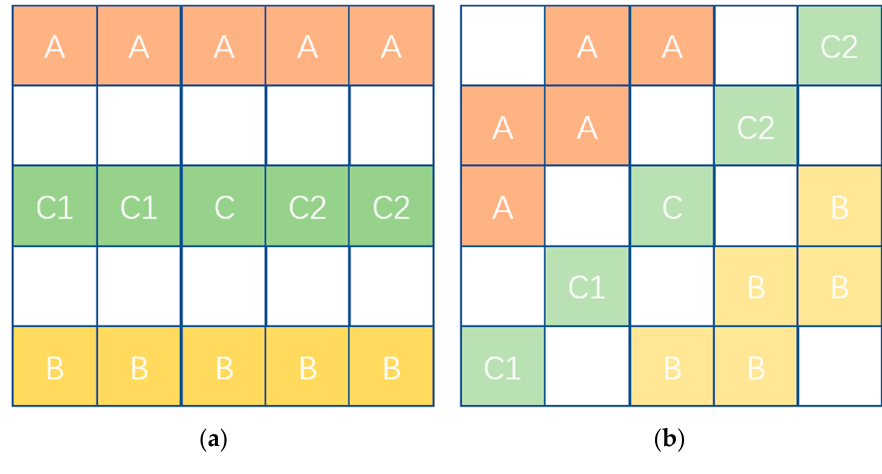
Figure 9. Window structure of two types of Duda operators. shown in Figure 10.